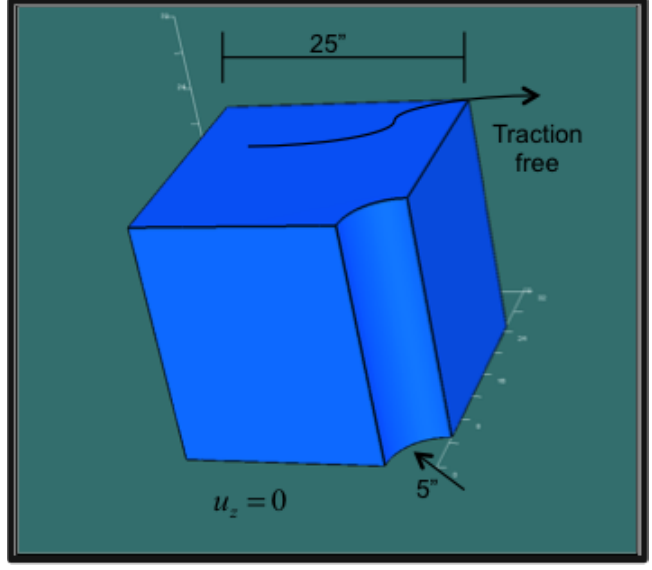
Figure 17. Bradley’s 3-D problem. Table 5. Bradley’s problem partitioning and parallel